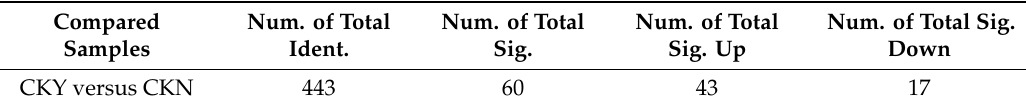
Table 5. Di ff erential metabolite level analysis Table 5. Differential metabolite level analysis results.